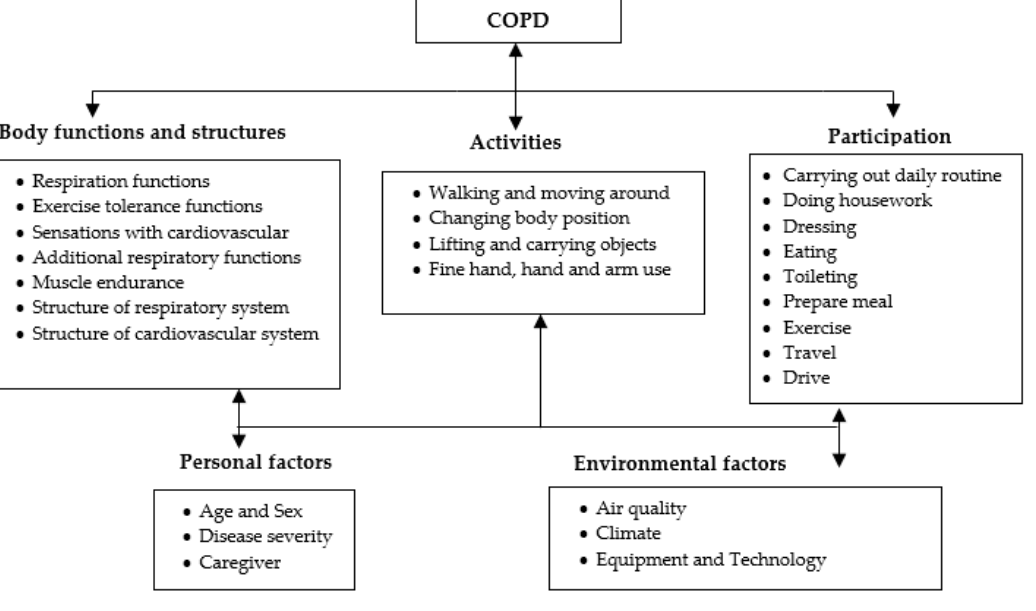
Figure 10. ICF Figure 10. ICF model.